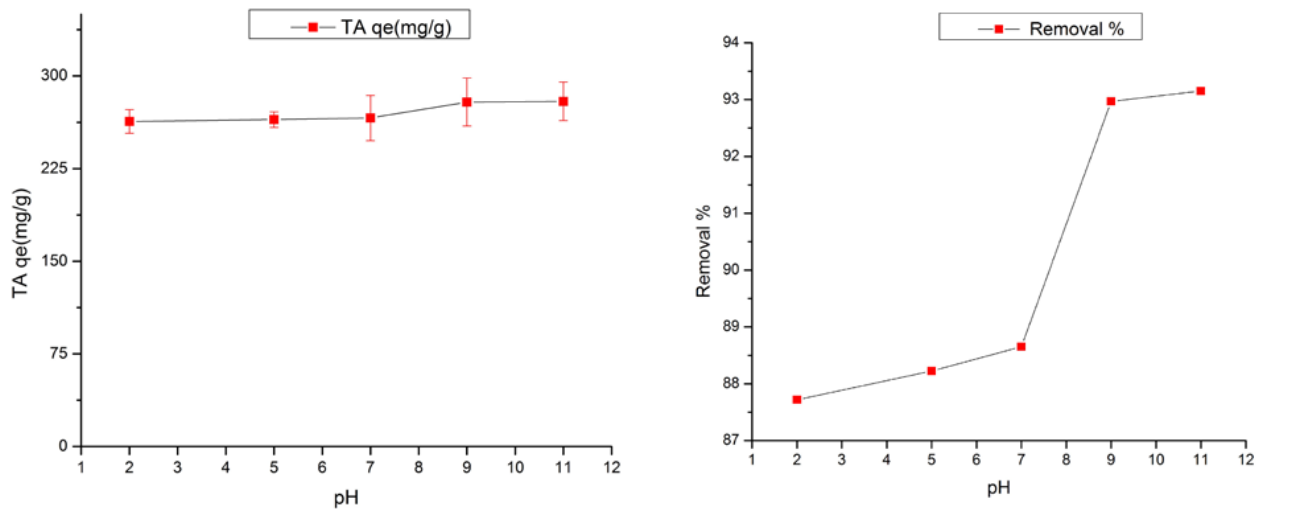
Figure 9. Effect of pH on TA adsorption. Adsorption conditions: SS dosage = 100 mg; T = 293 K; time = 225 min; initial concentration = 300 mg/L, volume = 100 mL.